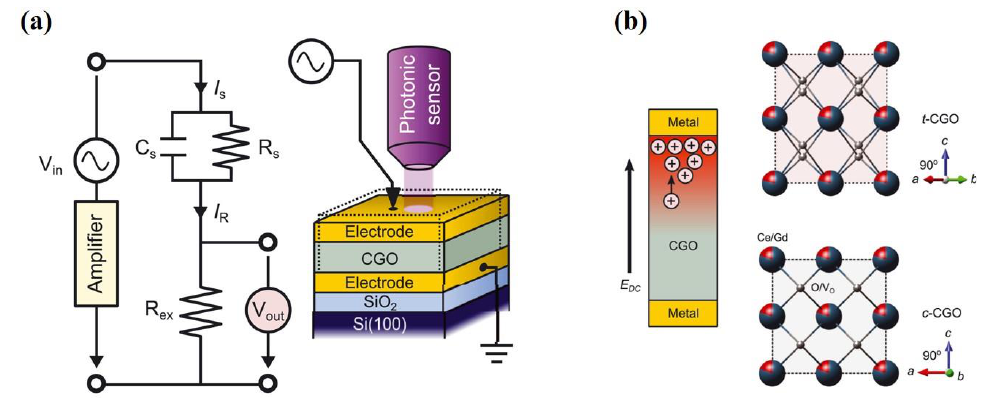
Figure 10. ( a ) Schematics of the experimental setup. The thicknesses of CeO 2–x (CGO) films are in the range of ~1.25 to ~1.8 mm [26]. From [26]. Reprinted with permission from AAAS. ( b ) The phase transition of CGO from cubic to tetragonal phase under an EDC [26]. From [26]. Reprinted with permission from AAAS.